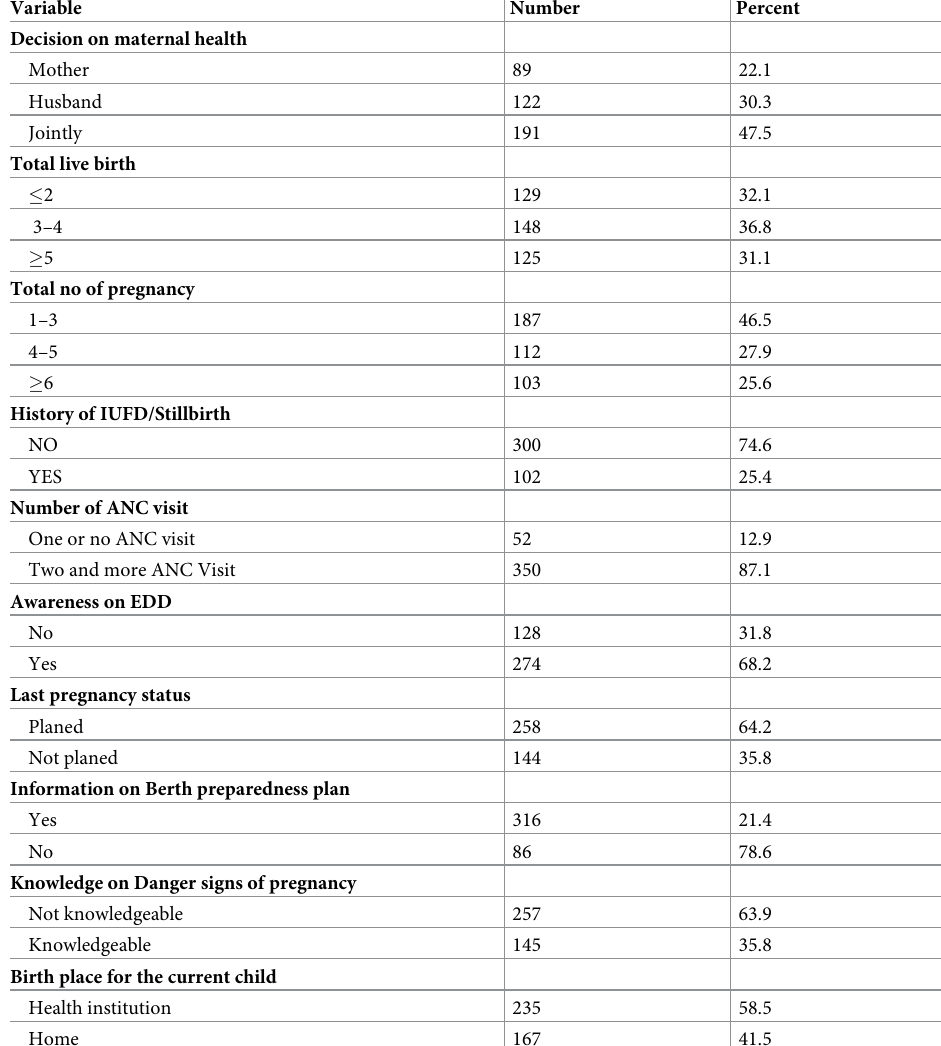
Table 2. Reproductive and obstetric related factors of the study participants in Dabat district, north west Ethio- pia,